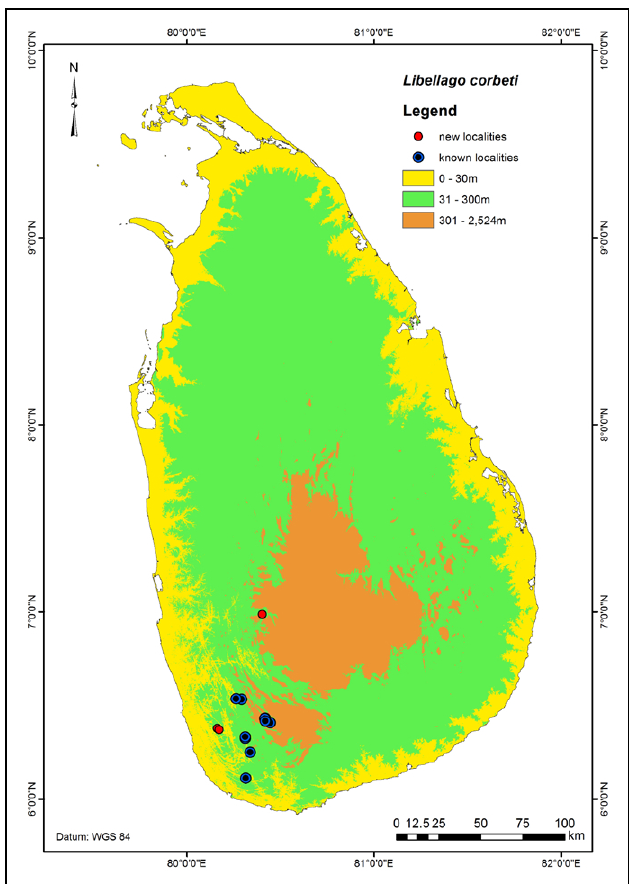
Figure 2. Distribution of Libellago corbeti with new localities.